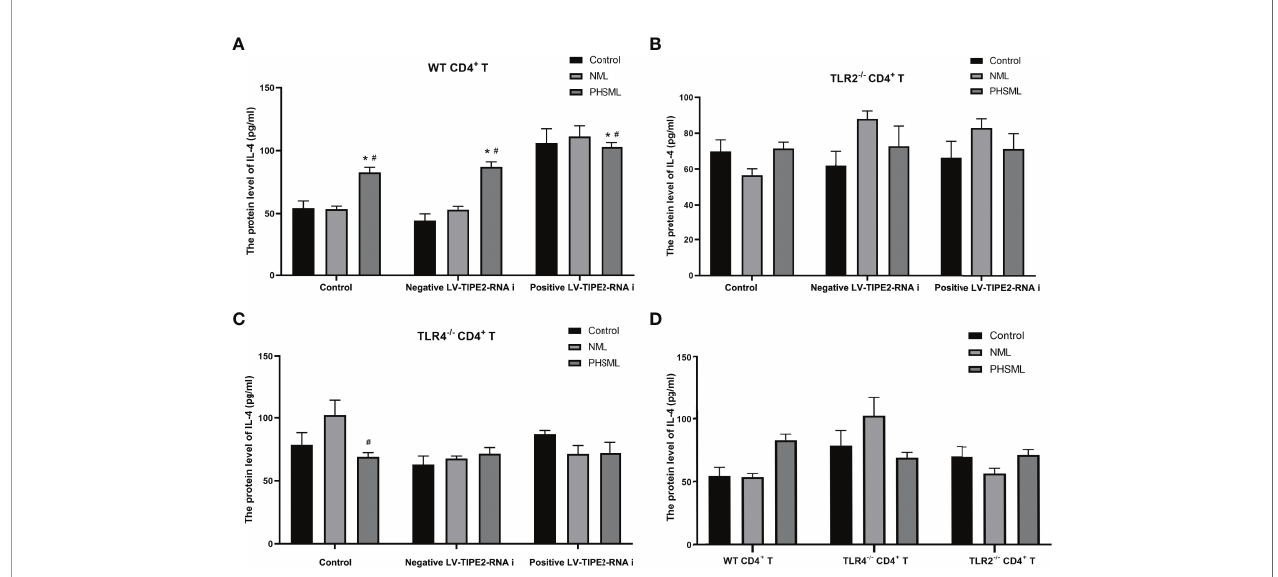
FIGURE 8 | The changes of IL-4 production in CD4 + T cells isolated from various mice. (A) The production of IL-4 in cultural supernatant of CD4 + T cells from WT mice infected with TIPE2 shRNA following by the stimulation with PHSML detected by ELISA; (B) The production of IL-4 in cultural supernatant of CD4 + T cells from TLR2 -/- mice infected with TIPE2 shRNA following by the stimulation with PHSML detected by ELISA; (C) The production of IL-4 in cultural supernatant of CD4 + T cells from TLR4 -/- mice infected with TIPE2 shRNA following by the stimulation with PHSML detected by ELISA; (D) The production of IL-4 in cultural supernatant of